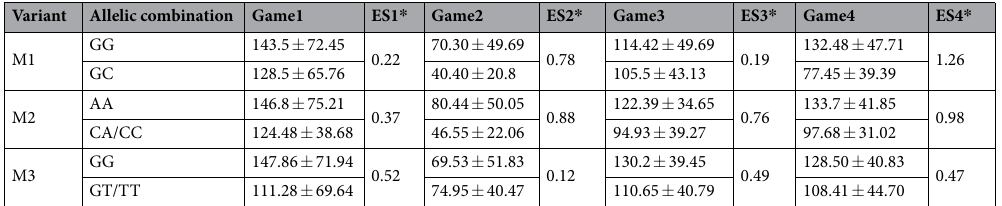
Table 4. Association of genotypes with scores obtained through computerized games. * ES = Cohen’s D Effect size indicating standardized difference between two